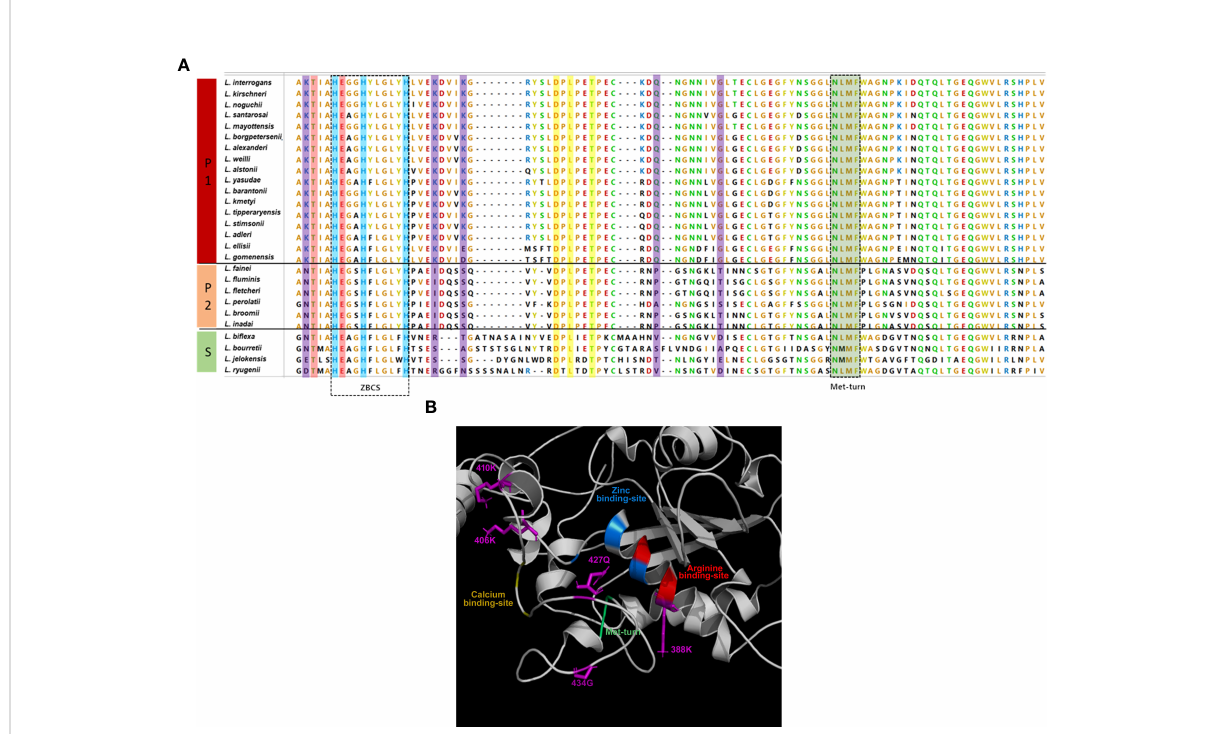
FIGURE 3 Comparative analysis of leptolysin catalytic domain. (A) Pathogenic (P1), intermediate (P2) and saprophytic (S) leptolysins (amino acids 387 - 480) were aligned by Muscle. Zinc, calcium, and arginine binding sites are colored in blue, yellow, and red, while the Met-turn is colored in green; variable residues are colored in purple; (B) Zinc, calcium, and arginine -binding sites, Met-turn and variants found in P2 and S leptolysins at positions K388, K406, K410, Q427 and G434 (purple) are